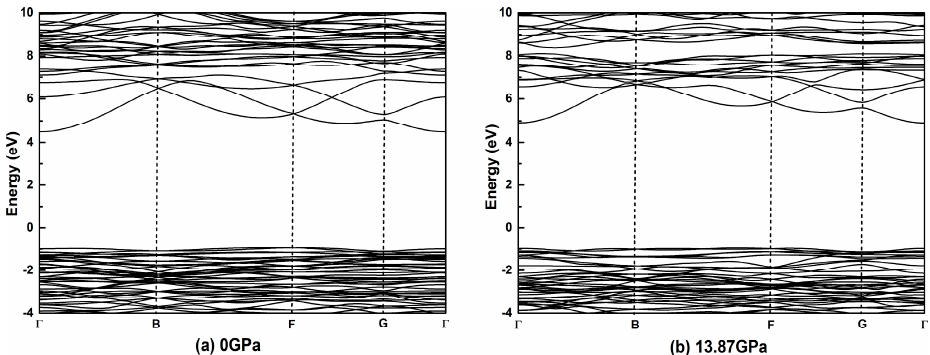
Figure 5. The band structure of pyrophyllite [Al 4 Si 8 O 20 (OH) 4 ] along high-symmetry lines in the Brillouin zone. ( a ) The band structure at 0 GPa; ( b ) The band structure at 13.87 GPa.